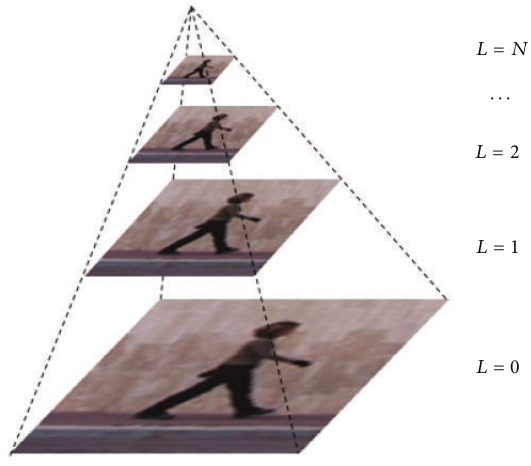
Figure 7: The Gaussian Pyramid.